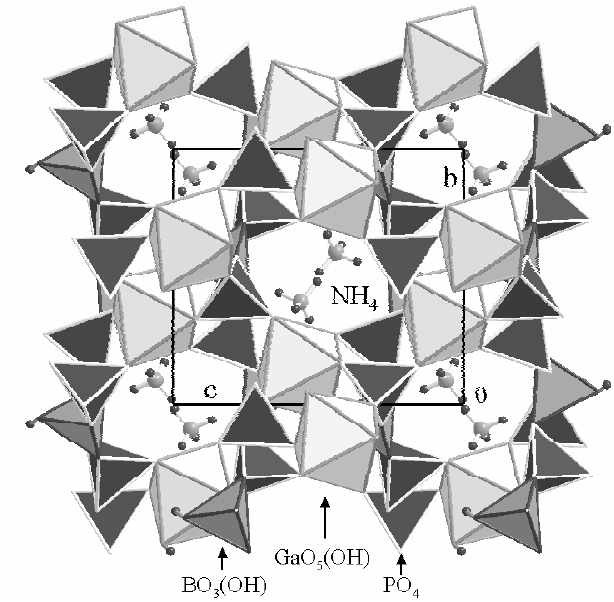
Table 1. Data collection and handling.